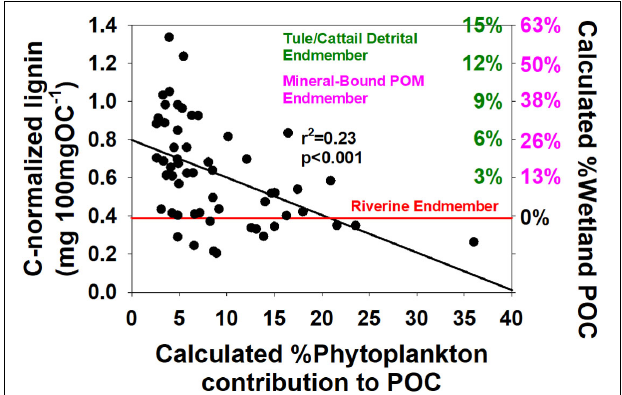
FIGURE 7 | Carbon-normalized lignin yields, (cid:51) 8 , vs. %Phytoplankton-derived carbon, and %wetland-derived materials calculated from a two-endmember mixing model. The red line represents the average (cid:51) 8 for the Sacramento River endmember at station 711, green scale on the right represents tule/cattail senescent plant material as an endmember, while the pink represents a mineral-bound endmember as estimated from the Mississippi